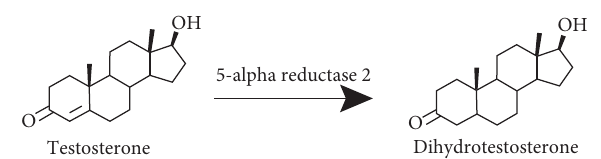
Figure 1: Conversion of testosterone to dihydrotestosterone cat- alyzed by 5-alpha reductase